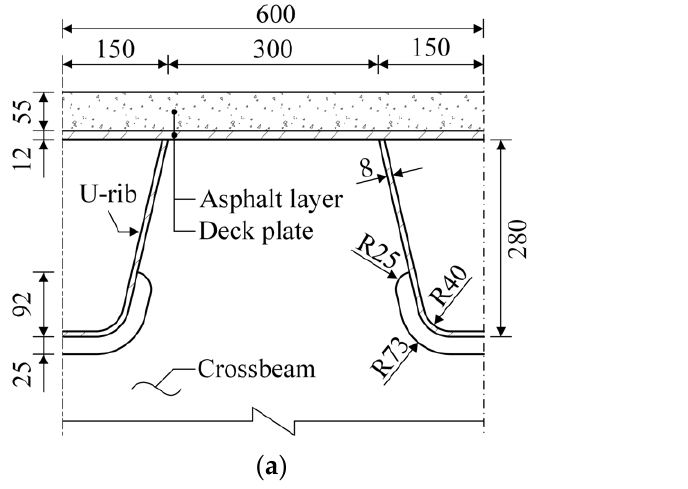
Figure 1. Details and dimensions of OSDs (Unit: mm): ( a ) COSD; ( b )